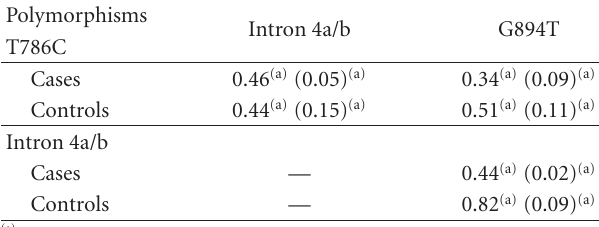
Table 4: Pairwise linkage disequilibrium metrics [ D (cid:4) ,( r 2 )] for NOS3 polymorphisms in cases and controls.